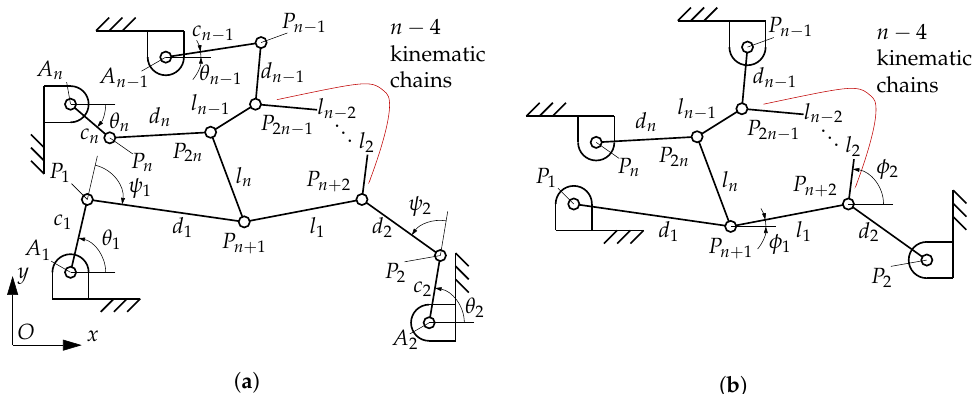
Figure 2. ( a ) schematic of the n -RRR robot; ( b ) the corresponding n -RR structure, obtained by fixing the actuated angles θ i . Angles ψ i and φ i are represented only for the first two RRR chains, for